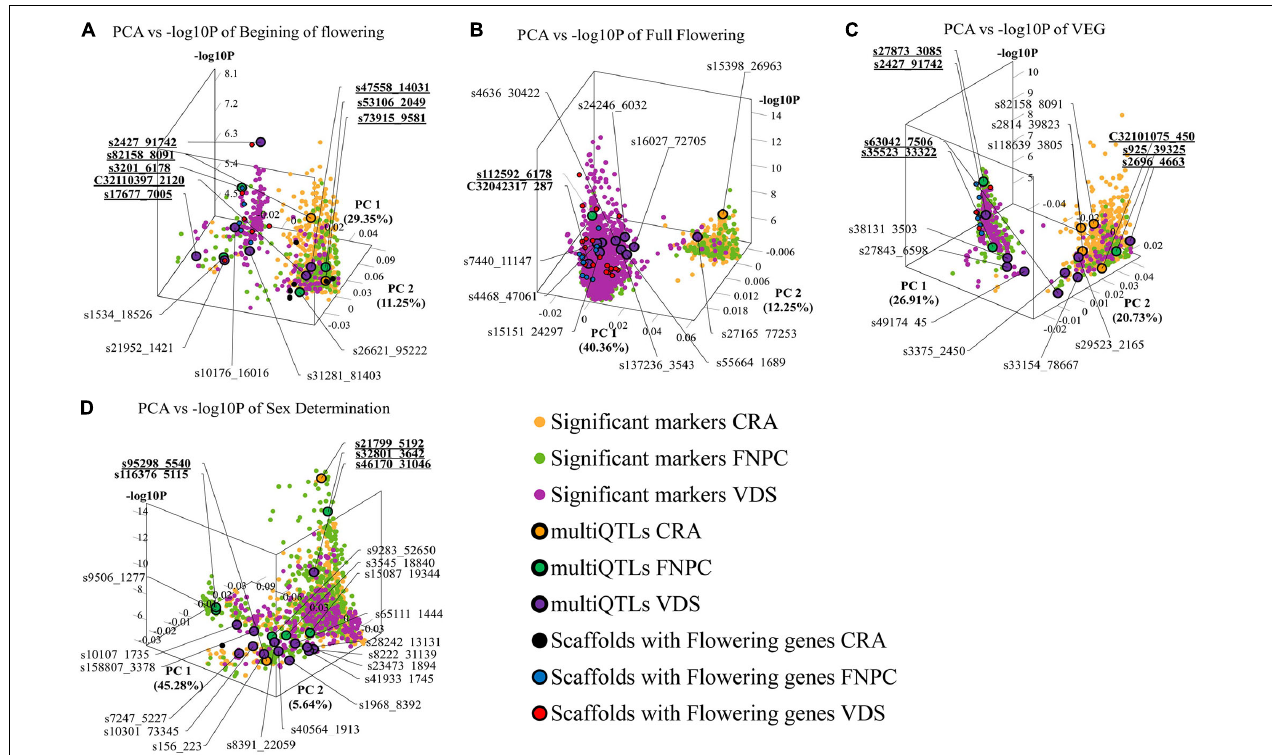
FIGURE 2 | 3D scatter plots of PCAs depicting variation in the allele frequency profiles of significant markers for, respectively, beginning of flowering (A) , full flowering (B) , length of the vegetative growth period (VEG) (C) , and sex determination (D) . X -axes indicate Principal Component 1, Y -axes indicate Principal Component 2, and Z -axes indicate the significant level of the GWAS association (–log 10 P). Each plot is shown in the angle that represents better the results. Each dot represents a significant QTL-marker from the GWAS analysis. Orange, green, and purple dots indicate significant QTL-markers detected in CRA, FNPC, and VDS, respectively. Orange, green, and purple dots with a black circle represent the representative QTL-markers of QTLs of the MultiQTL models from CRA, FNPC, and VDS, respectively. Black, blue, and red dots with a black circle represent scaffolds with significant QTL-markers associated to the trait in the GWAS with flowering/sex related genes in CRA, FNPC, and VDS, respectively ( Table 3 ). QTL-names in bold and underlined indicate representative QTL-markers from different MultiQTLs models that belong to QTL regions across